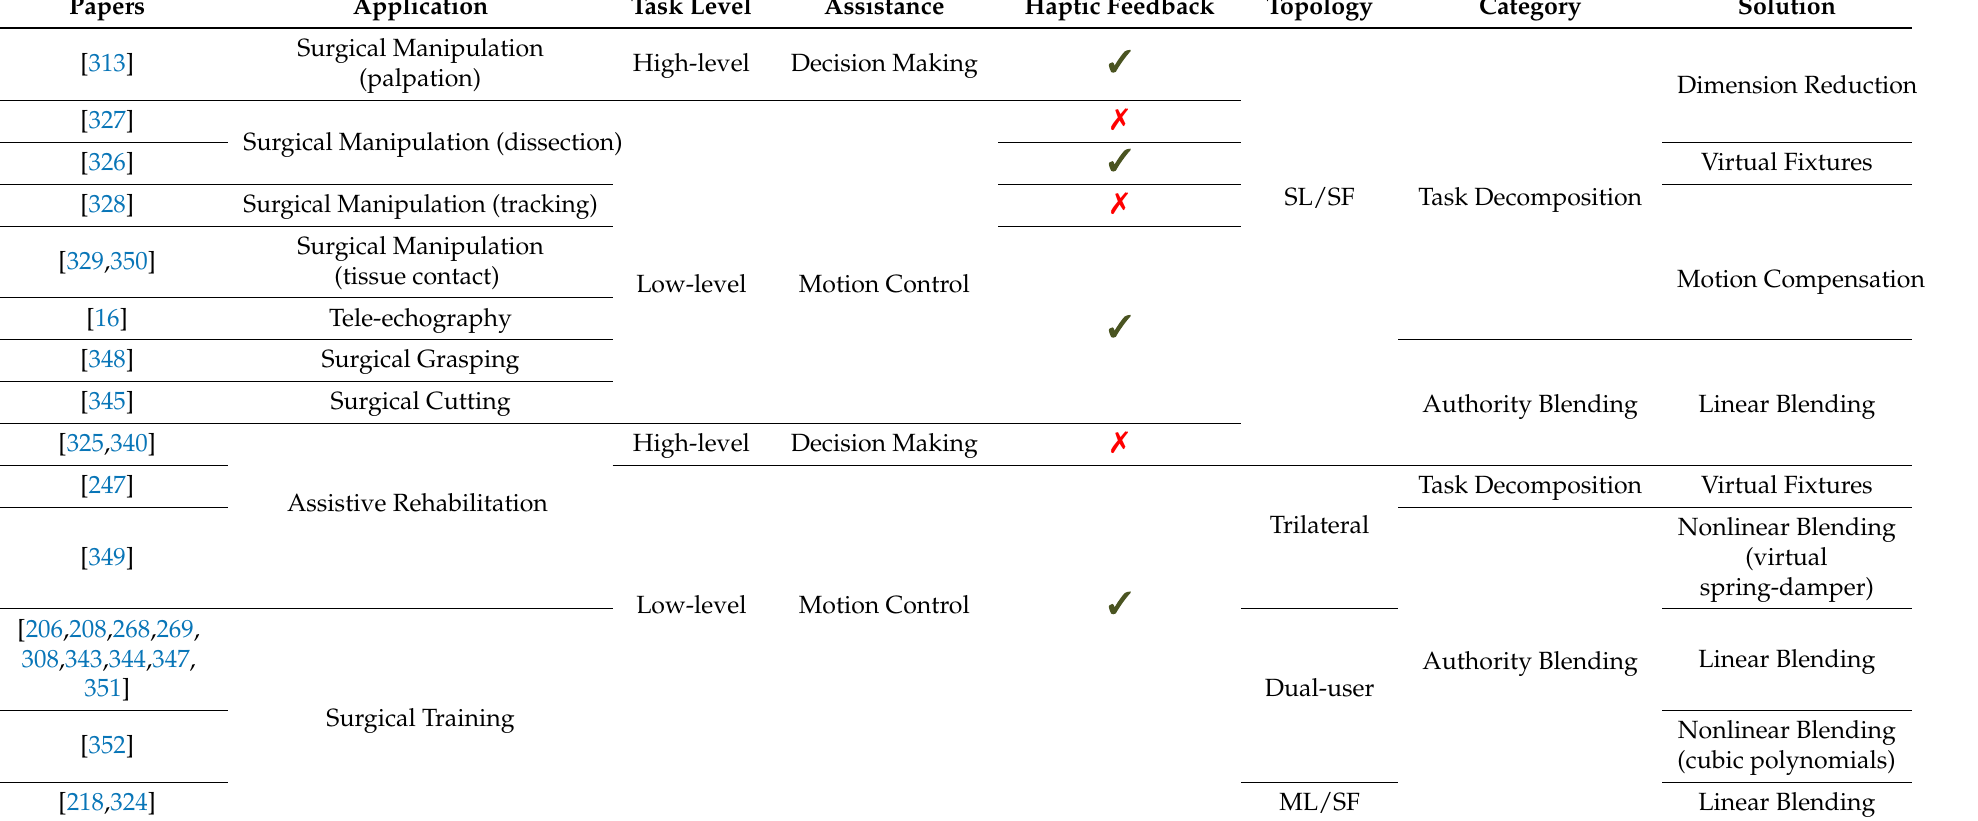
Table 1. Shared control samples for teletherapy